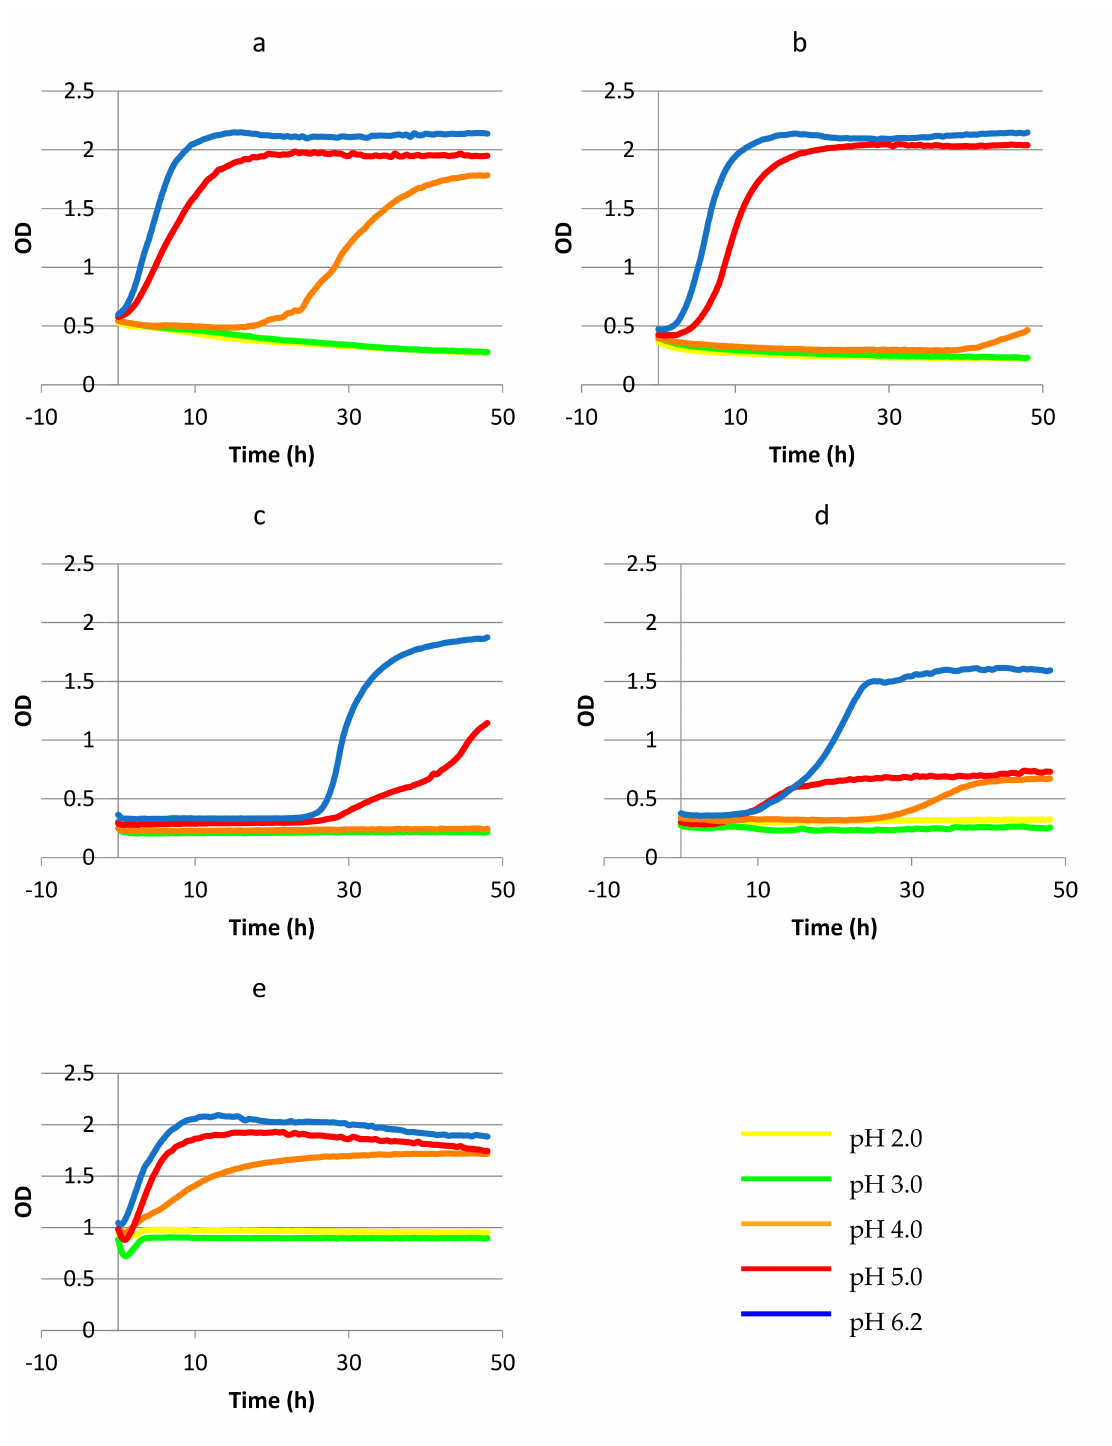
Figure 3. Changes in the optical density (OD 600 ) during culture of commercial probiotics preparations: ( a ) Lb. rhamnosus GG ATCC 53103; ( b ) Bifidobacterium BB-12; ( c ) Lb. casei ; ( d ) Lb. acidophilus ; ( e ) Lb. plantarum in MRS medium with different pH (2.0; 3.0; 4.0; 5.0; 6.2), ( p < 0.05). The number of repeats for each treatment n = 3. Letters marked with the same color define a homogeneous group within one pH value among the tested variants of the experiment (a given color correlates with the pH value and a given letter correlates with a given homogeneous group within pH